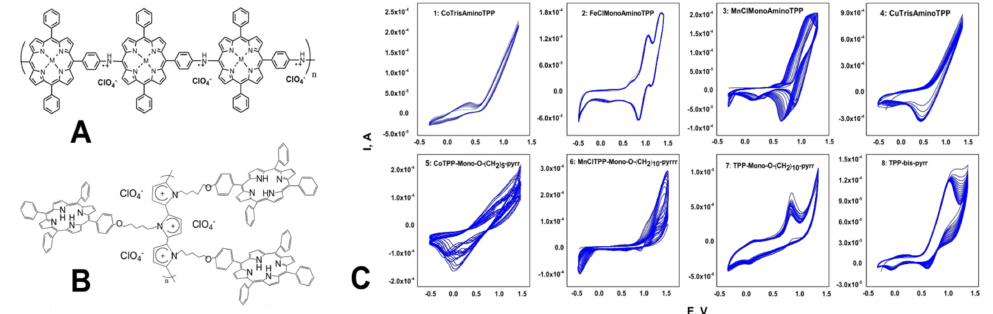
Figure 2. Schematic presentation of PANI ( A ) and PPy ( B ) porphyrin-substituted electropolymers formation; ( C ) CV curves of oxidative polymerization of compounds 1 – 8 on PT WE by repeated potential scans at 100